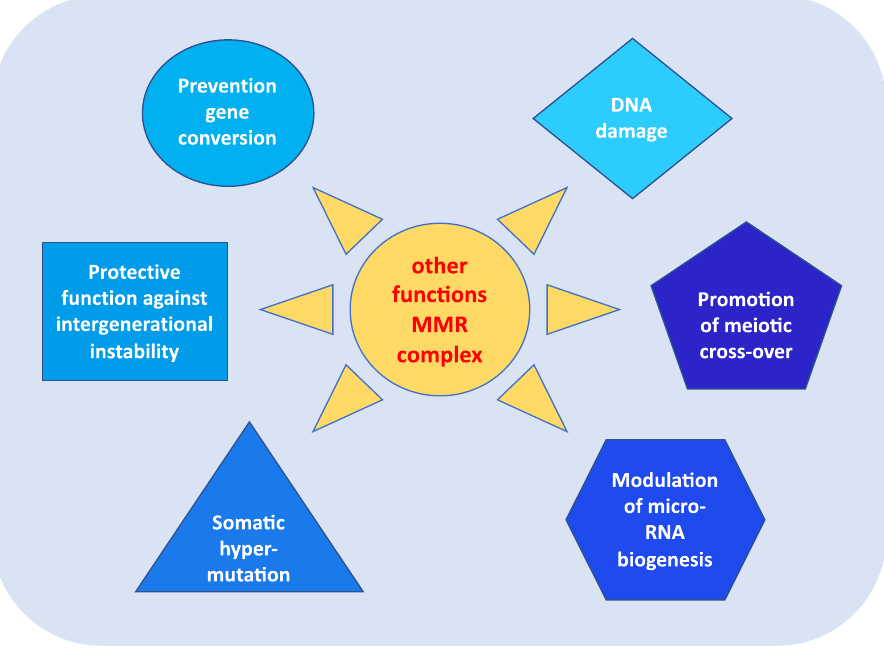
Figure 2 . Other functions of MMR